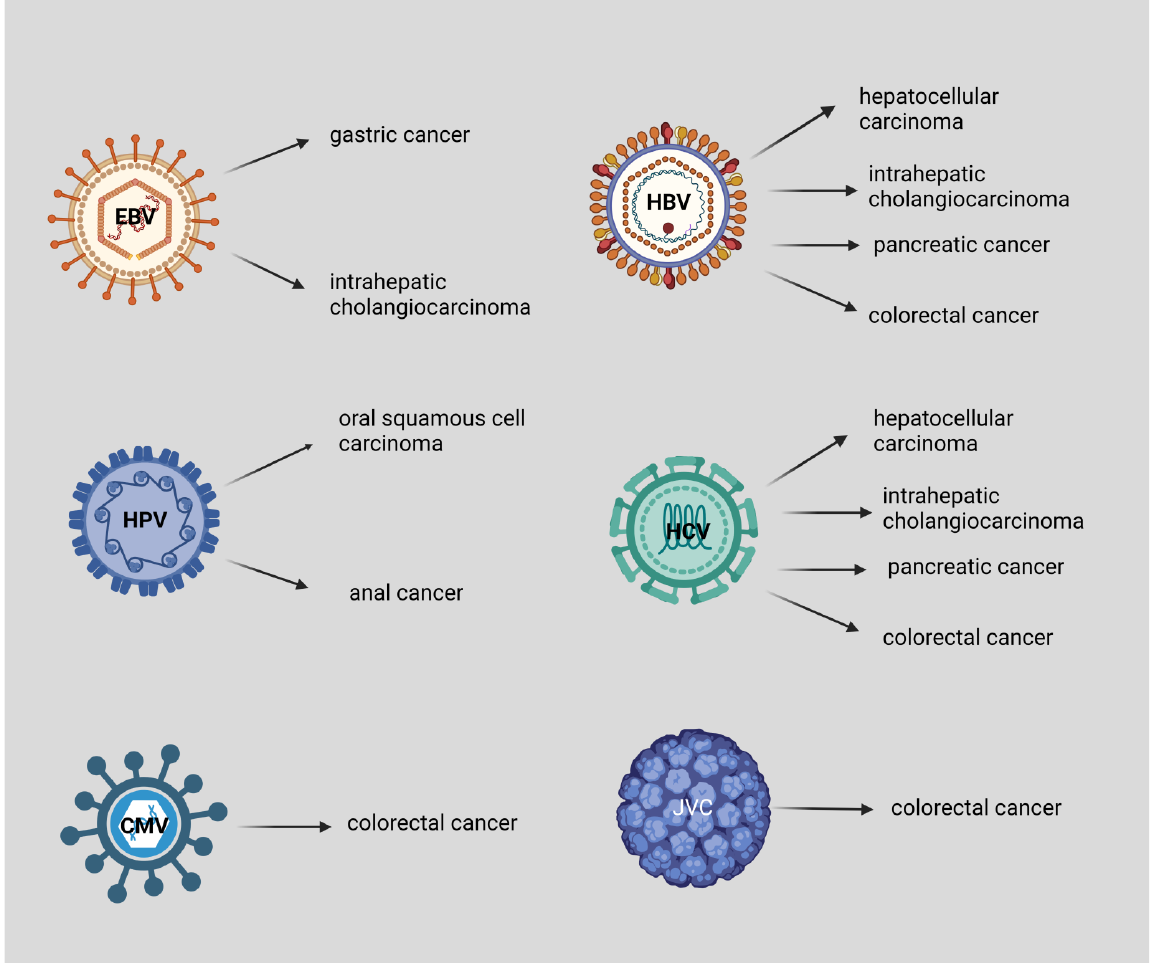
Figure 2. EBV is associated with gastric cancer and intrahepatic cholangiocarcinoma, HPV with oral squamous cell carcinoma, and anal cancer. Both HBV and HCV are associated with hepatocellular carcinoma, intrahepatic cholangiocarcinoma, pancreatic cancer, and colorectal cancer. Moreover, CMV and JCV are associated with colorectal cancer. This figure was created based on the tools pro- vided by Biorender.com (accessed on 3 September 2022).